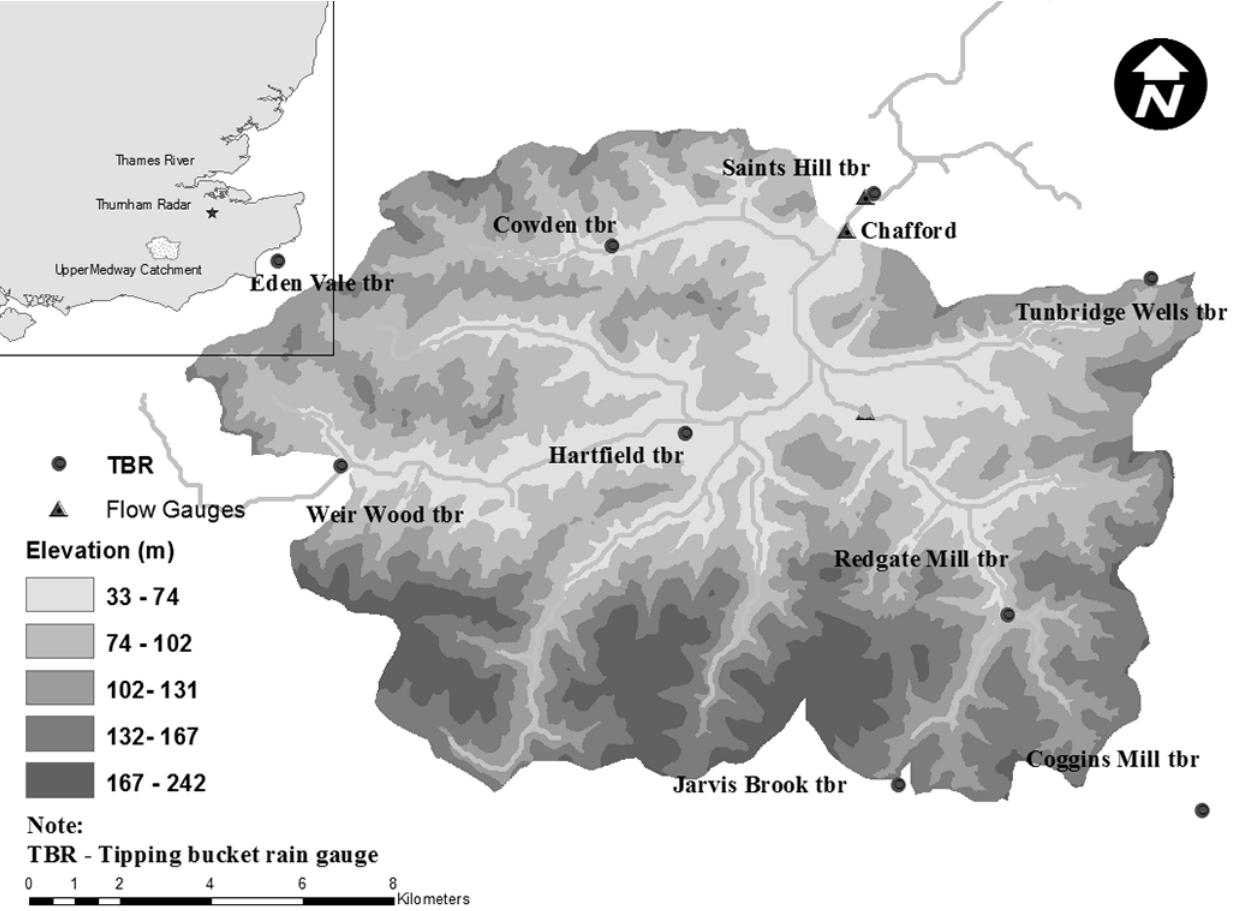
Figure 1. Map of rain gauges and flow gauge locations on the Upper Medway catchment (source: Zhu and Cluckie,